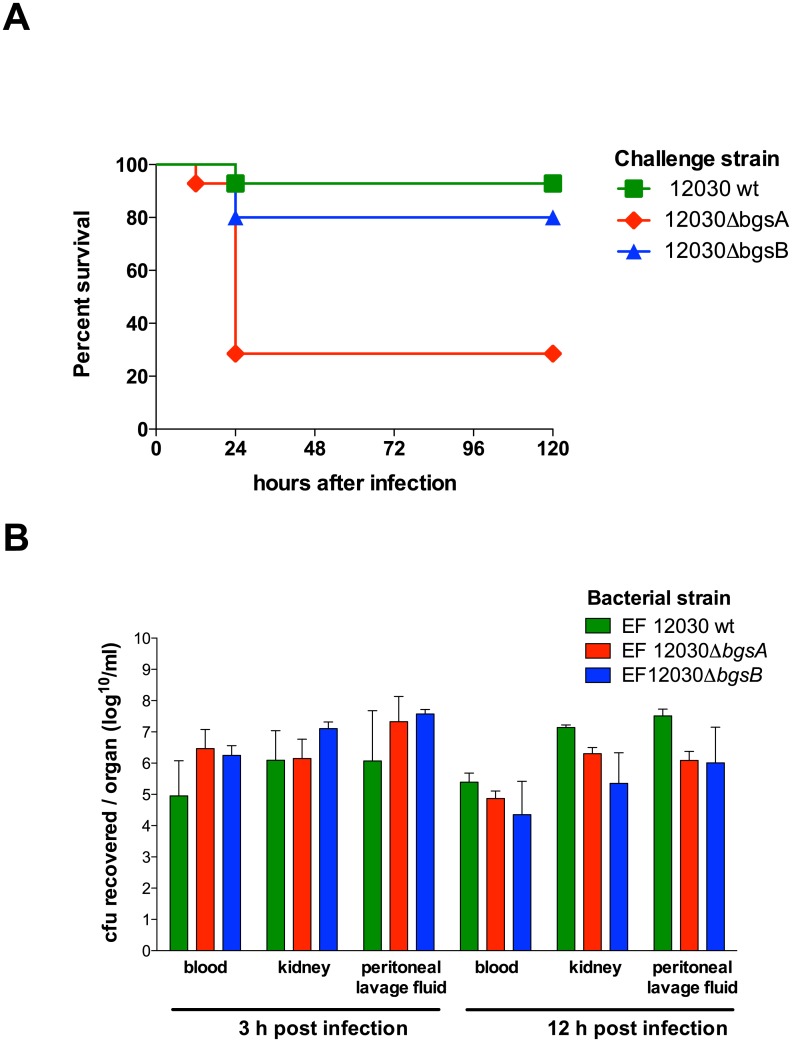
Survival and bacterial load of BALB/c mice after intraperitoneal infection with E. faecalis strains.Survival after infection with 1.3 x 109
E. faecalis. P = 0.0096 EF 12030 wild-type vs. ΔbgsA determined by the log-rank test (A). Bacterial counts 3 h and 12 h after i.p. challenge (inoculum 2.0 x 109 cfu per mouse, 14 mice per group). The bacterial load is expressed as the log10 (cfu) per ml ± SEM (B). P > 0.05 EF 12030 wild-type vs. ΔbgsA vs. ΔbgsB at 3 h and 12 h by 2-way ANOVA.